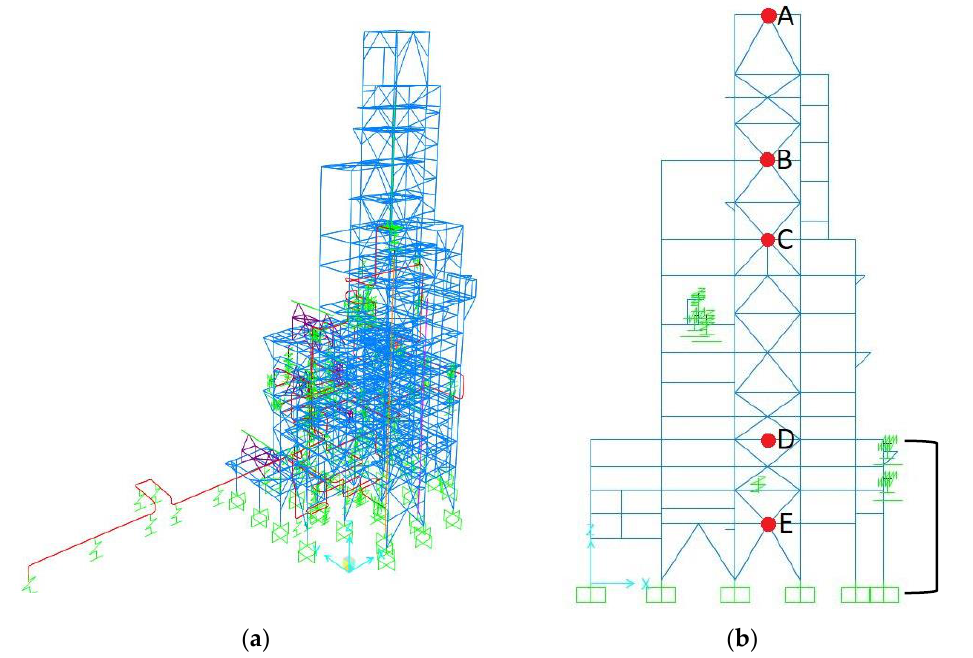
Figure 5. Steel process unit using SAP2000 [35]: ( a ) 3D view and ( b ) 2D view.